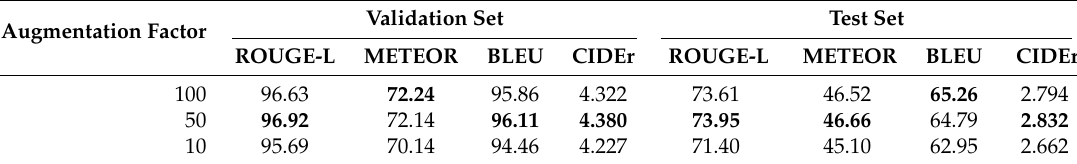
Table 7. Effects of data augmentation by random frame sampling on sign language translation performance. Augmentation Factor